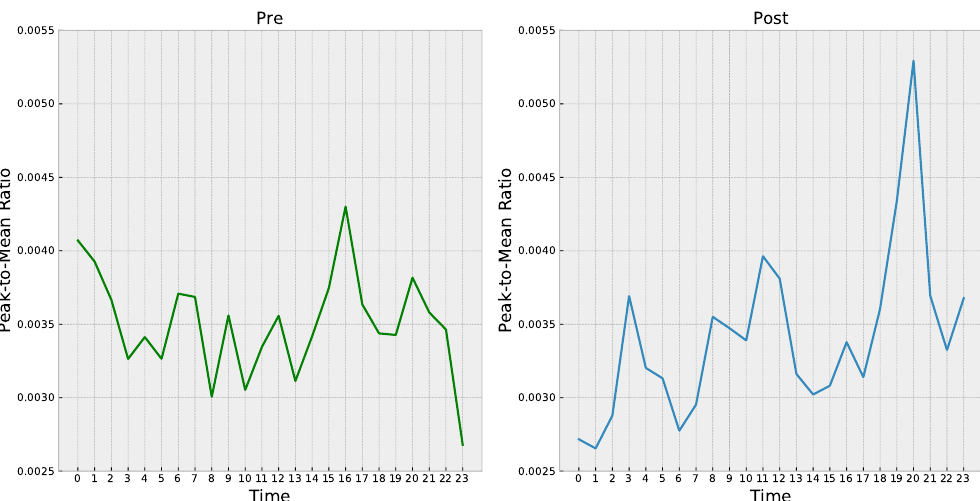
Figure 9. Comparison of hour-indexed peak-to-mean ratios for system frequency, showing an increase in 8 p.m. high frequency occurrence post-lockdown. The plot on the left represents w/c 02/03/20 and the one on the right represents